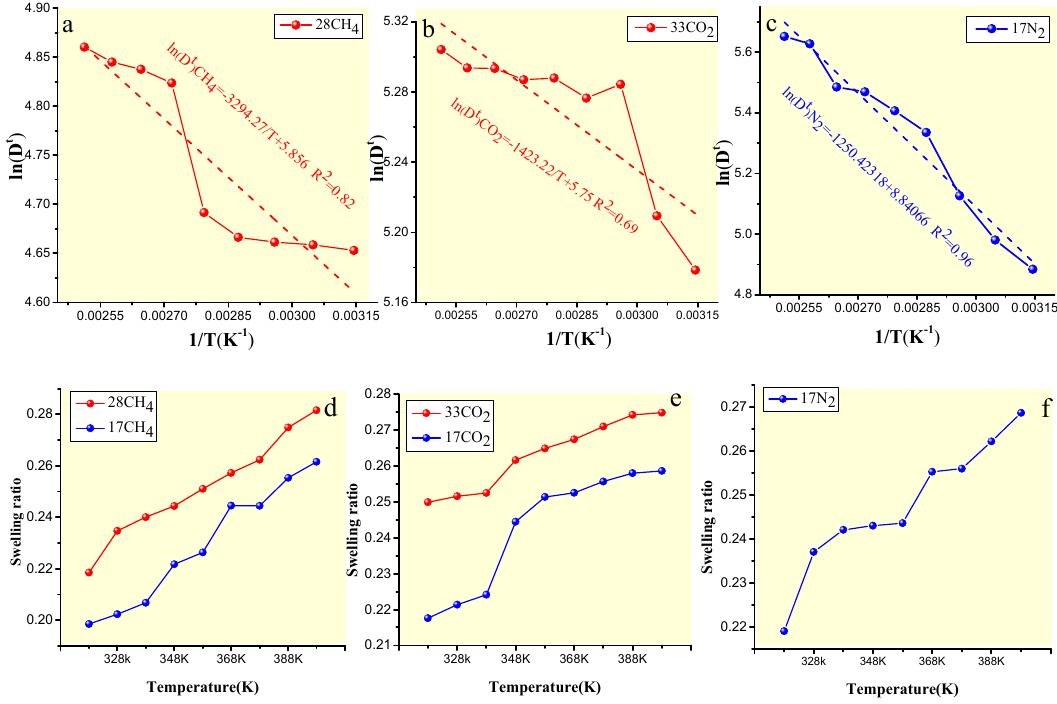
Figure 13. Relationship between ln(D t ) and 1/T for CH 4 ( a ), CO 2 ( b ), and N 2 ( c ) diffusions in vitrinite macromolecules, and the swelling ratios for CH 4 ( d ), CO 2 ( e ), and N 2 ( f ).